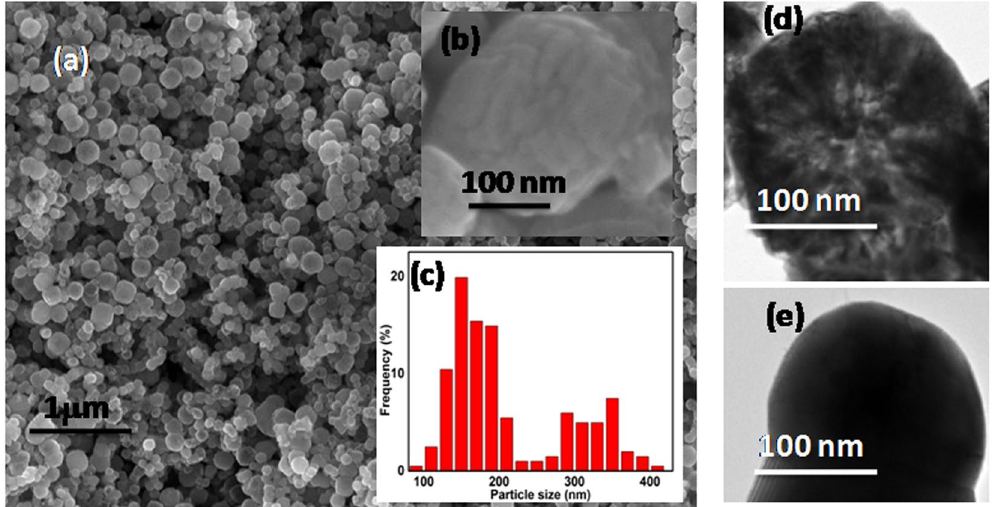
Figure 2. FESEM image of FeCo ( a ) as-prepared ( b ) magnified image and the ( c ) particle size distribution; TEM images of FeCo ( d ) as-prepared and ( e ) annealed at 700 °C.